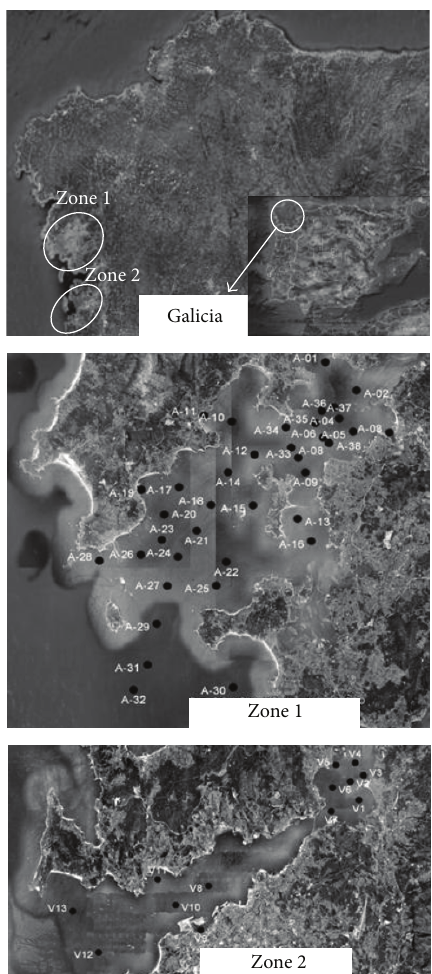
Figure 1: Map of sampling sites location at Galicia (NW